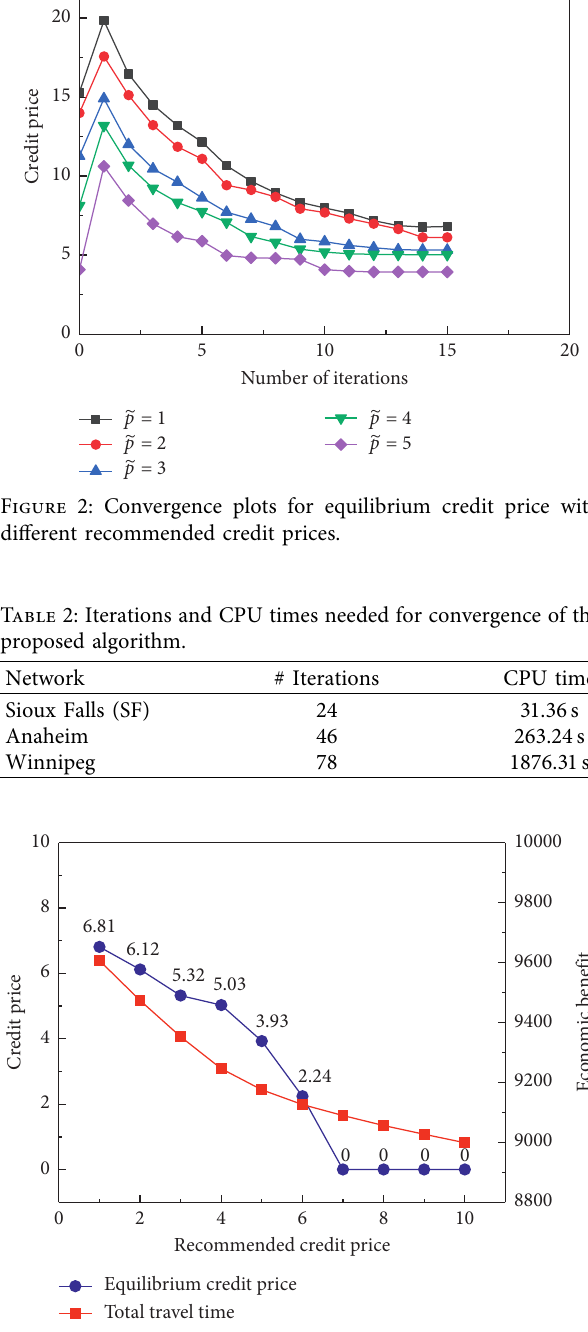
Figure 3: Change in equilibrium credit price and economic benefit with different recommended credit